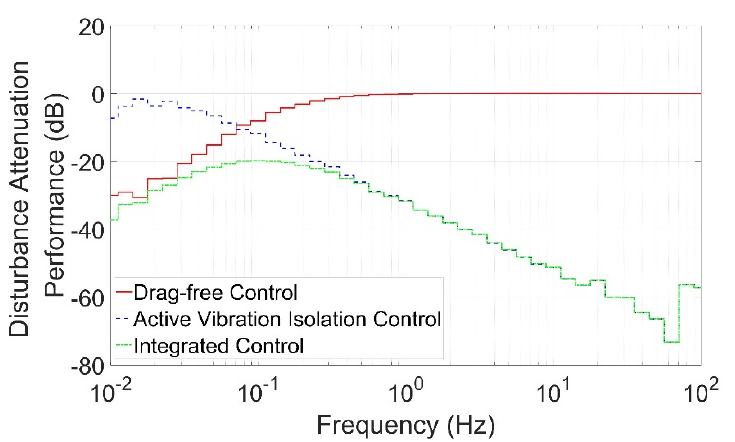
Figure 14. Disturbance attenuation performance of the improved DFP spacecraft.